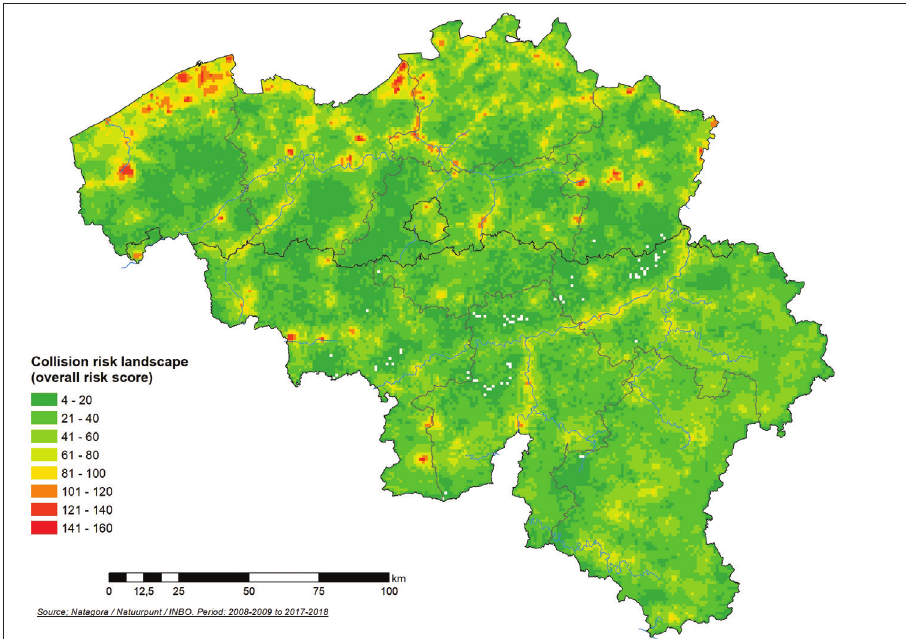
Figure 1. The transmission lines collision risk map for the whole of Belgium, shows the risk at any loca- tion in the country. This is a theoretical score not accounting for the current presence/absence of a power line, based only on the additive presence or high abundance of the sensitive